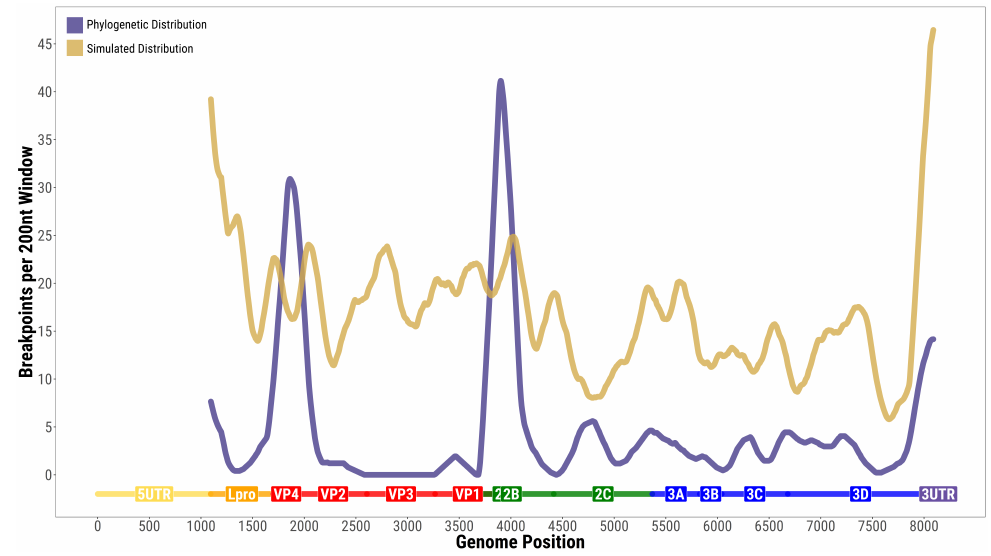
Figure 3. Phylogenetic signal of recombination along the nucleotide sequence of the polyprotein: Number of recombination breakpoints over a 200-bp window from RDP4 analysis of the real data (violet) and of simulated data (gold) obtained by adding 50 simulated recombination events per 200-bp